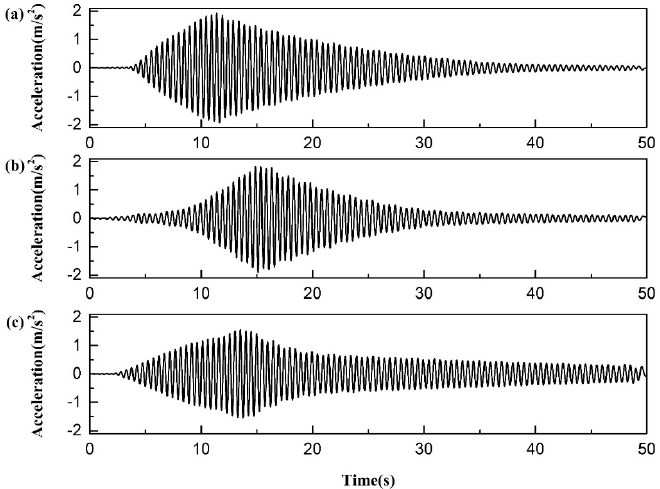
Figure 9. Damping ratios in the first four modes of the cable versus constant voltage of the MR damper.